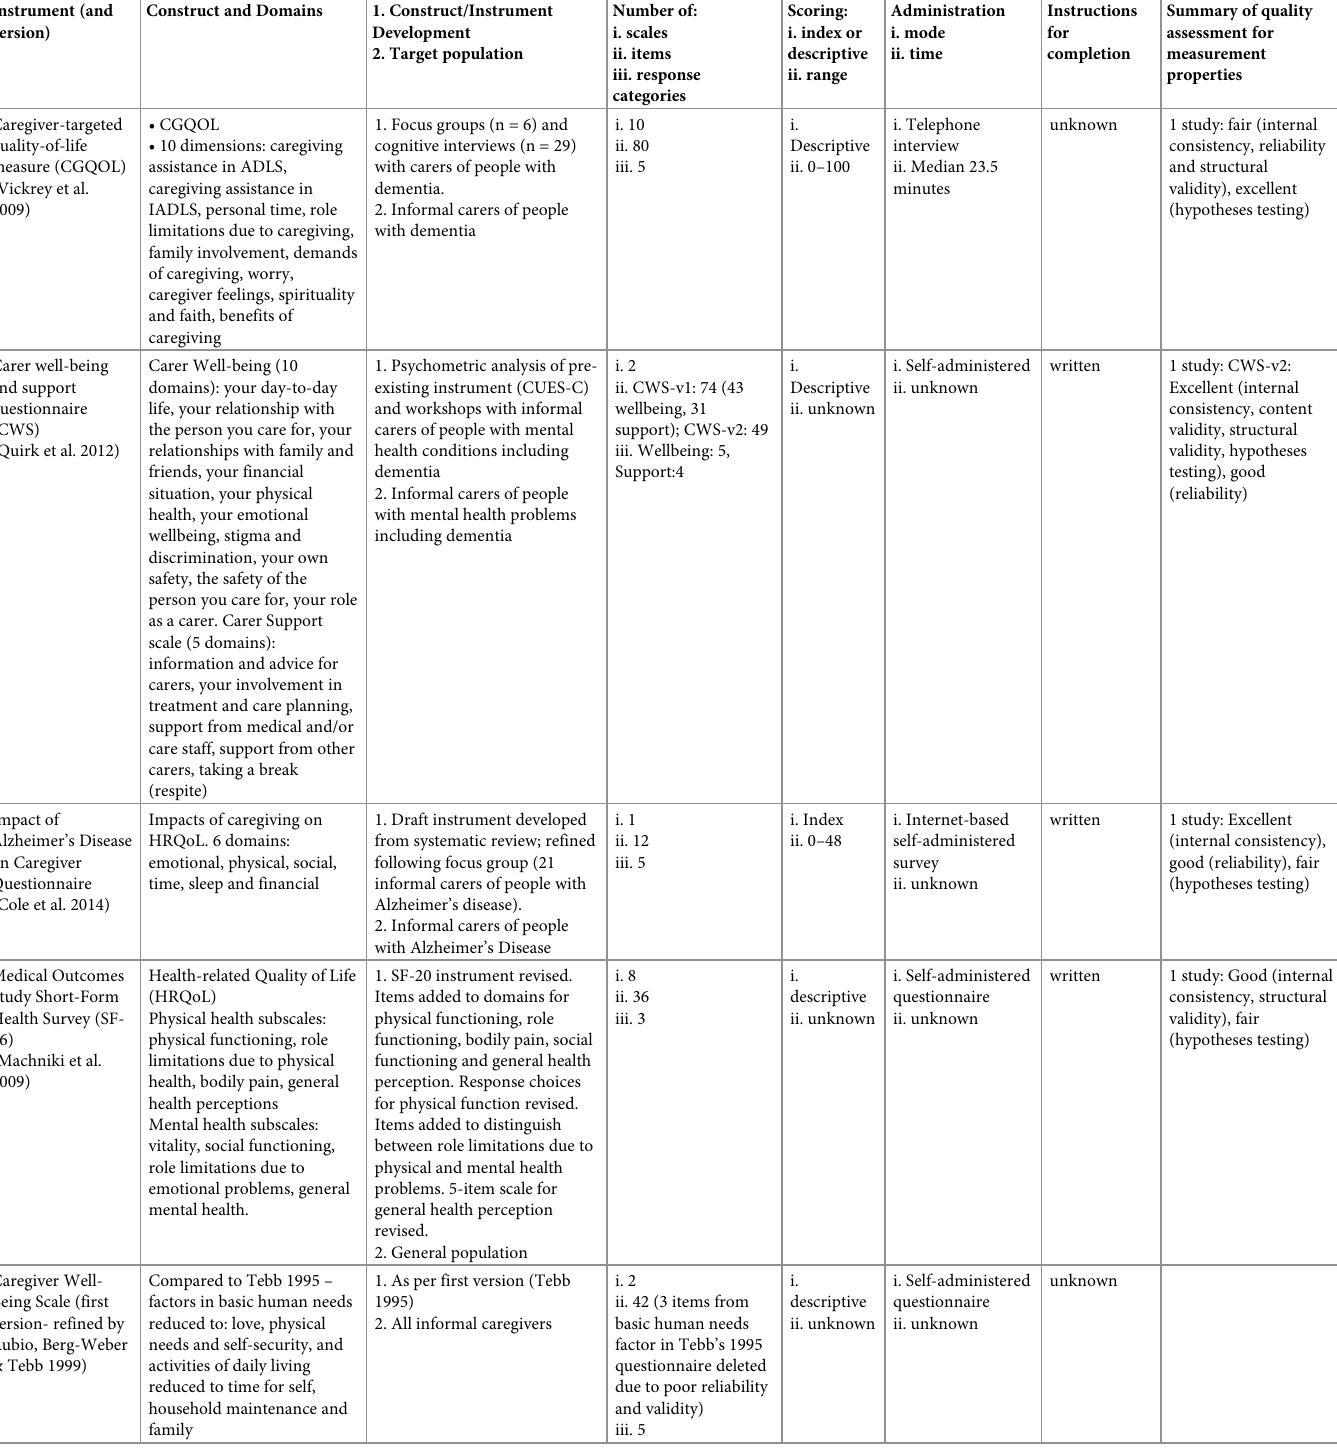
Table 3. Characteristics of included instruments and summary of quality